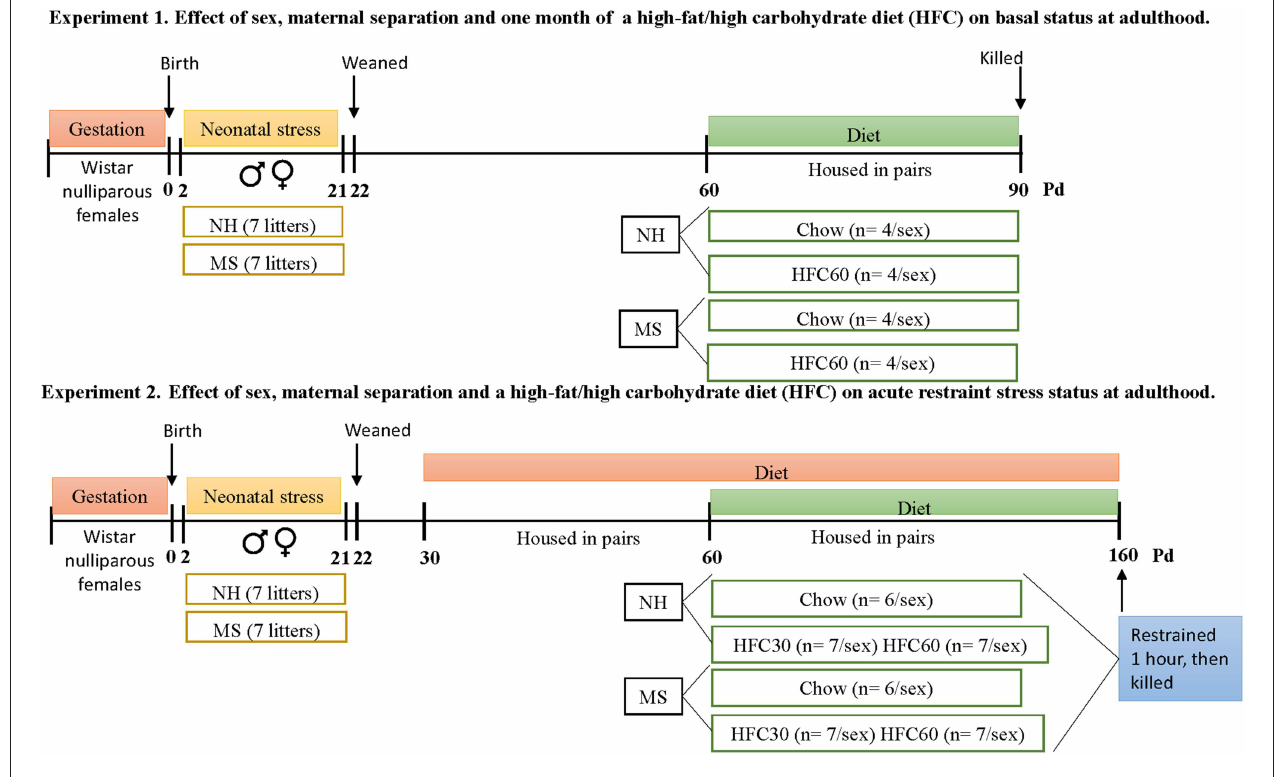
FIGURE 1 | Timeline of protocols followed in experiments 1 and 2. Each experimental group from both experiments was composed by rats from a different litter, to avoid litter-mates within the same group. Abbreviations: HFC30, fed a high-fat/high-carbohydrate diet from postnatal day 30; HFC60, fed a high-fat/high-carbohydrate diet from postnatal day 60; MS, maternal separation; NH, non-handled; Pd, postnatal